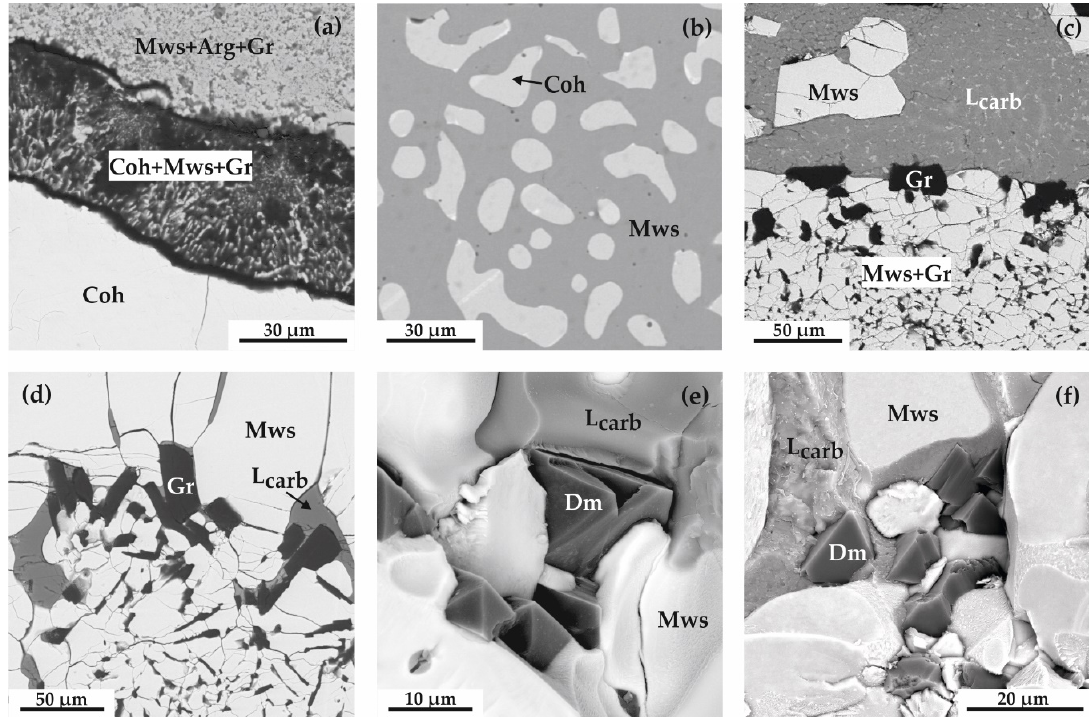
Figure 3. Scanning electron microscopy (SEM) photographs of sample fragments, which were produced in the carbonate-iron system: ( a ) graphite, cohenite and magnesiowüstite (reaction zone) at the contact between coarse-grained cohenite and a fine-grained magnesiowüstite + aragonite + graphite aggregate (1000 °C, 7.5 GPa); ( b ) assemblage of magnesiowüstite and cohenite (reduced zone) (1450 ° С , 6.5 GPa); ( c) crystals of magnesiowüstite and graphite in a quenched carbonate melt (1450 ° С , 6.5 GPa); ( d ) crystals of magnesiowüstite and graphite, with quenching carbonate in interstices (1450 ° С , 6.5 GPa); ( e , f ) diamond crystals and quenching carbonate in coarse-grained magnesiowüstite interstices (1550 ° С , 7.5 GPa). Coh: cohenite, Mws: magnesiowüstite, Arg: